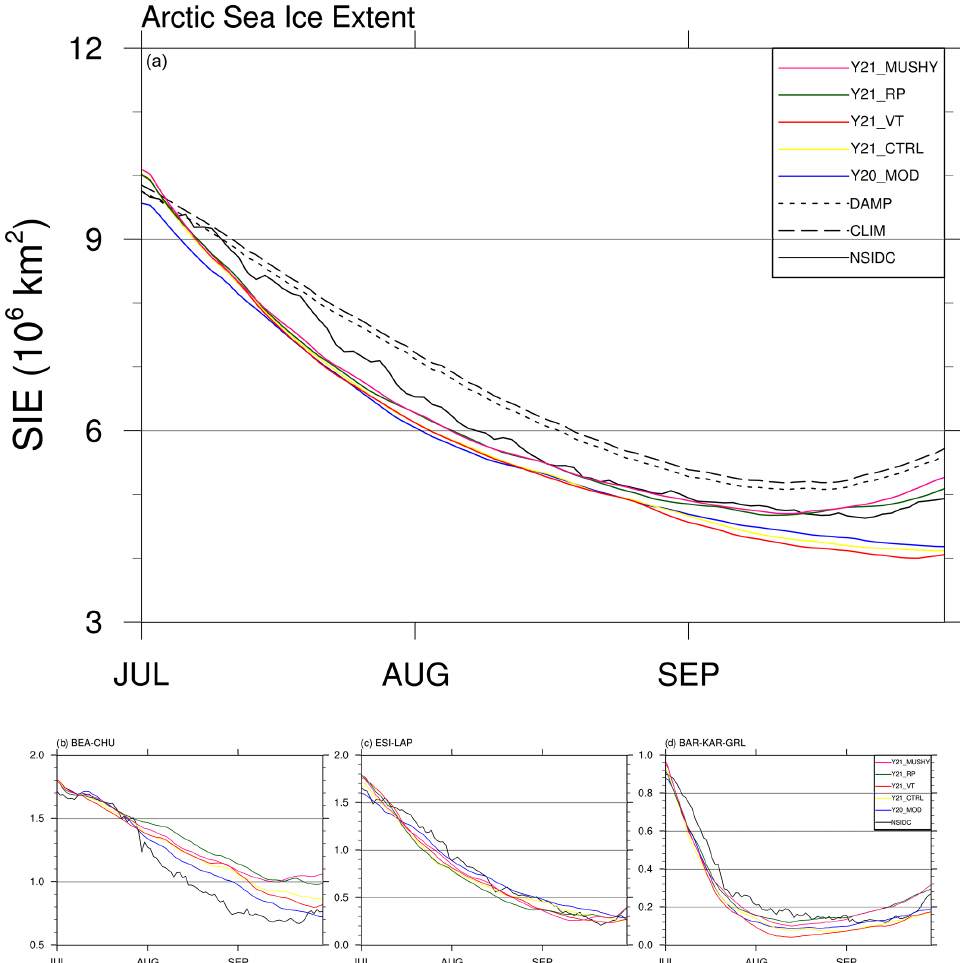
Figure 4. (a) Time series of Arctic sea ice extent for the observations (black line) and the ensemble mean of Y20_MOD (blue line, the original CAPS), Y21_CTRL (yellow line, changes in the atmospheric physics), Y21_VT (red line, changes in the ocean vertical coordinate), Y21_RP (green line, changes in the oceanic advection), and Y21_MUSHY (pink line, changes in sea ice thermodynamics). Dashed and dotted lines are the climatology and the damped anomaly persistence predictions. Bottom panel: time series of the observed (black line) and the ensemble mean of regional sea ice extents for Y20_MOD (blue line), Y21_CTRL (yellow line), Y21_VT (red line), Y21_RP (green line), and Y21_MUSHY (pink line) for the (a) Beaufort–Chukchi seas, (b) East Siberian–Laptev seas, and (c) Barents–Kara–Greenland